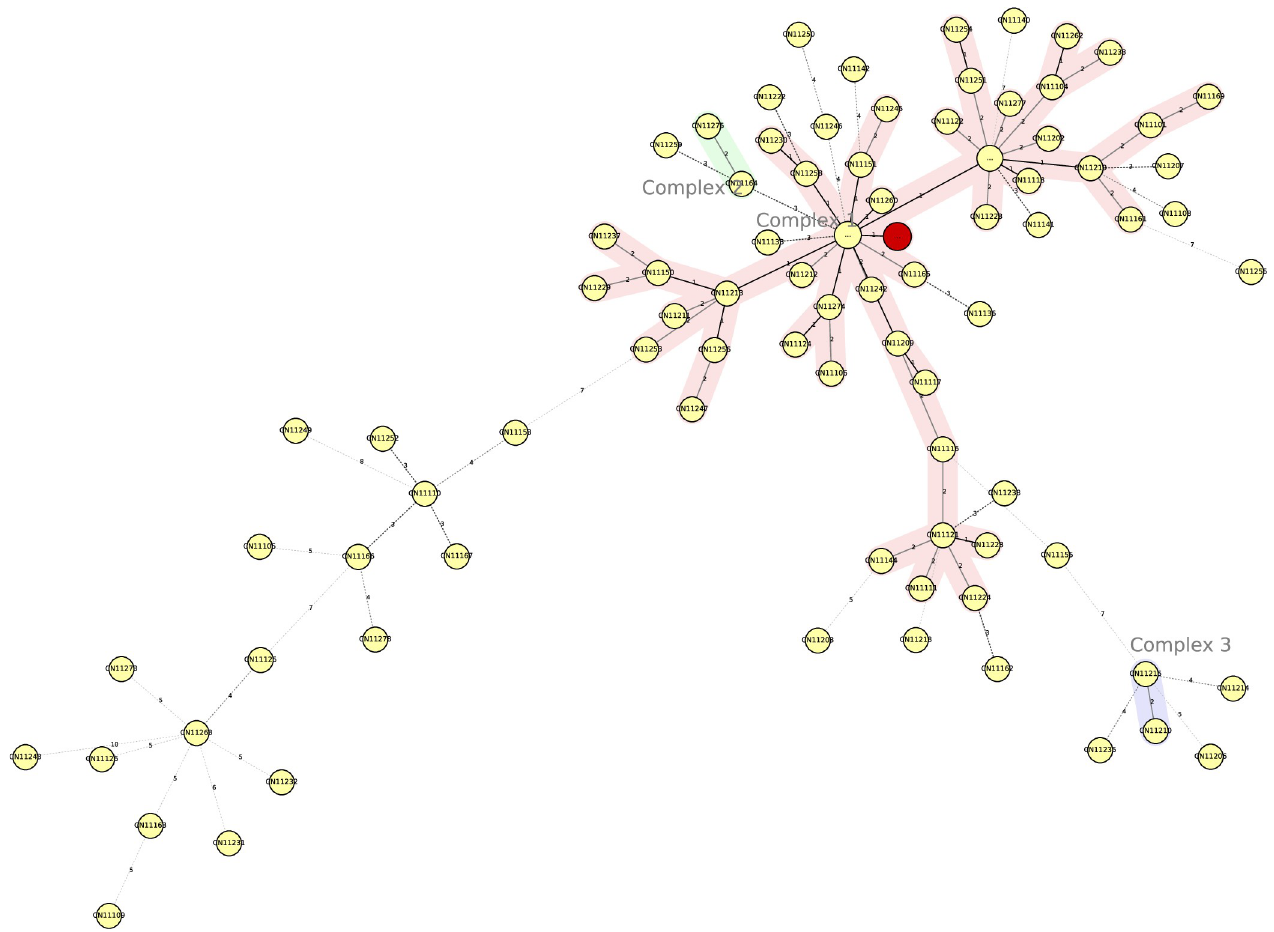
Fig 2. Minimum spanning tree showing clustering by MIRU-VNTR of four M. tuberculosis isolates from this outbreak. Each nodal point represents a cluster with identical genotypes, and the sizes of the nodal points are scaled to the number of strains in the cluster. Red shading indicates the outbreak group, which belong to the Beijing family. “Complex” refers to a group of strains with less than three loci variants that are linked with different colors.